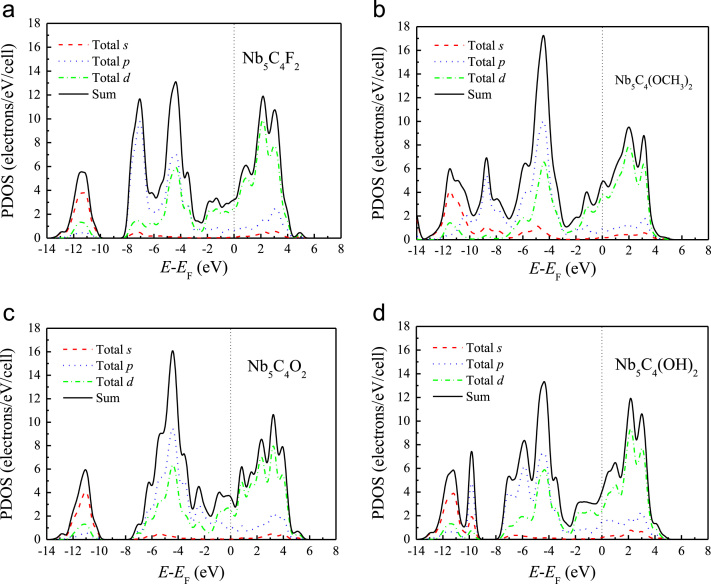
The PDOS of (a) Nb5C4F2, (b) Nb5C4(OCH3)2, (c) Nb5C4O2 and (d) Nb5C4(OH)2.